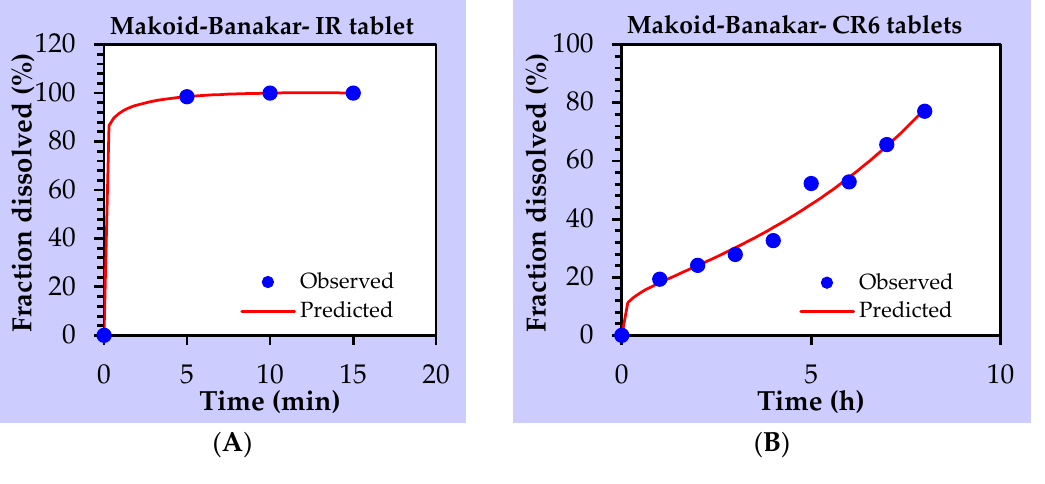
Figure 7. Release profiles of IR tablet ( A ) and CR6 tablet ( B ) fitted by Makoid–Banakar model.